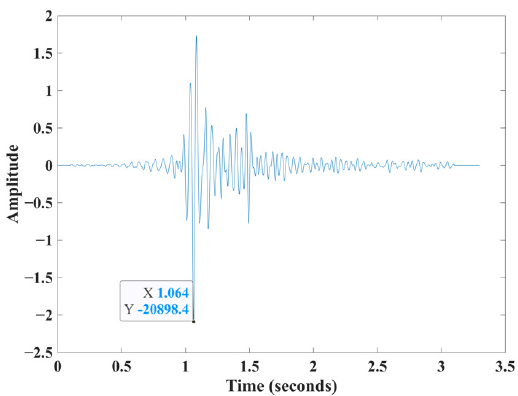
Figure 1. The first arrival travel time manually picked (at time 1.064 s) on a real Vibroseis trace to illustrate the HEEH method.